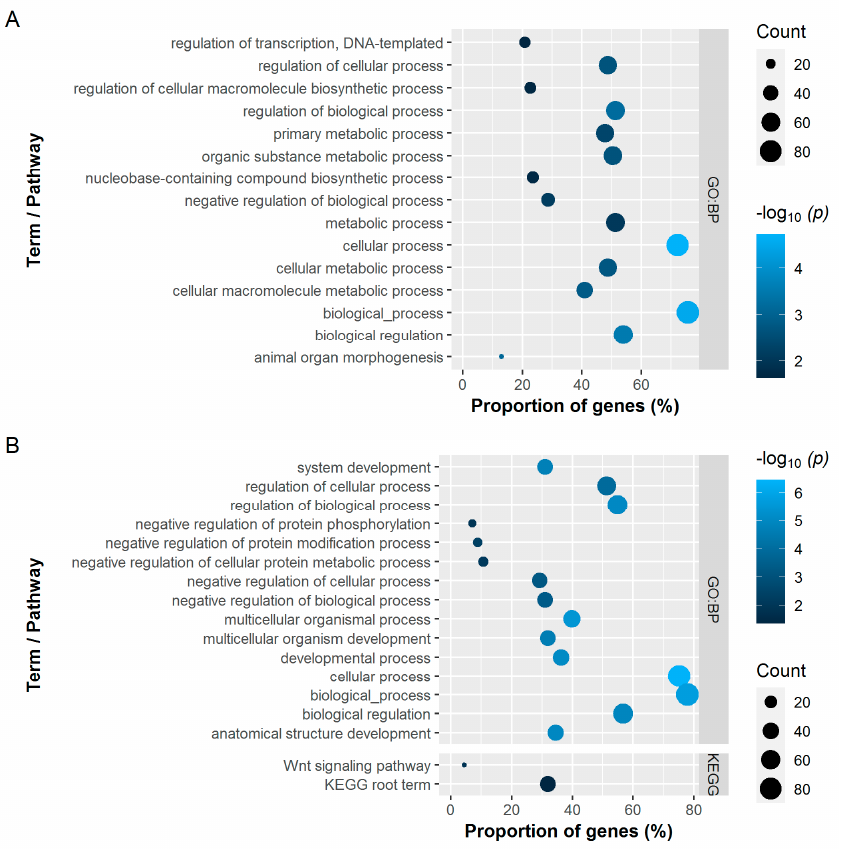
Figure 4. Significantly enriched Gene Ontology terms of the category biological processes (GO:BP; top 15 with the highest ‐ log 10 p ‐ values) and KEGG pathways for the bone breaking strength ( A ) and bone mineral density ( B ) of the humerus. The dot size represents the absolute number of genes enriched in the term. The proportion of enriched genes in all queried genes is represented on the x ‐ axis. The colour represents the ‐ log 10 transformed adjusted p ‐ values.